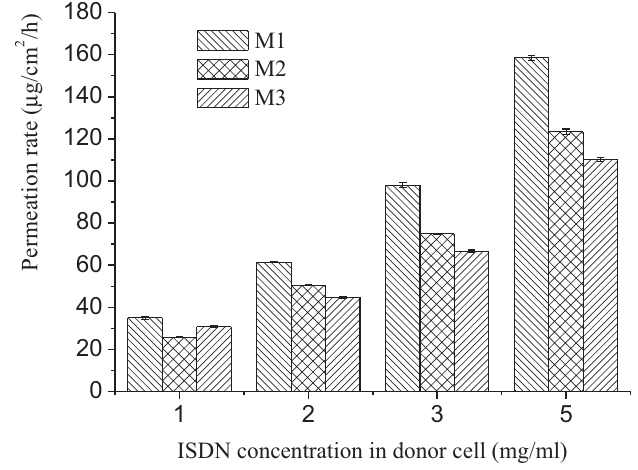
FIGURE 5 - The permeation of ISDN through different rate- controlling